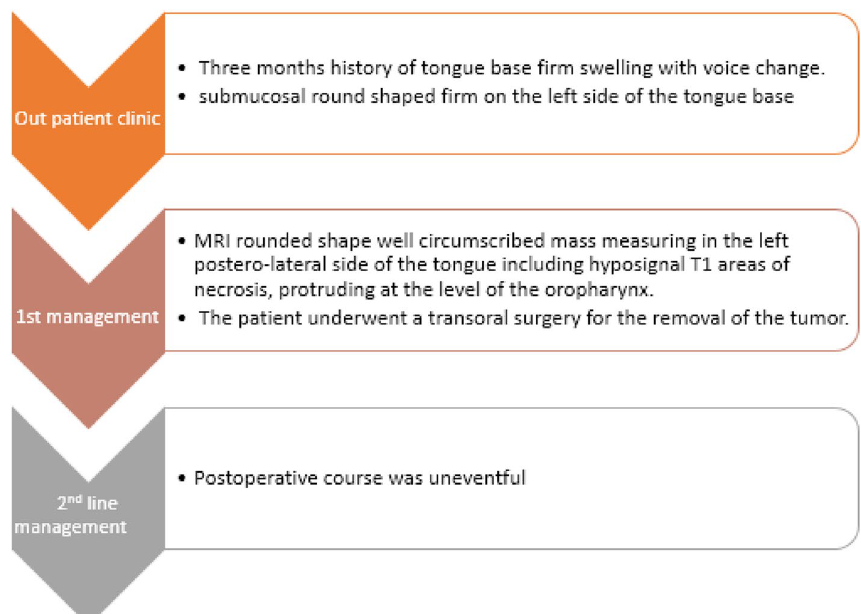
Fig. 6 The patient’s episodes of care timeline